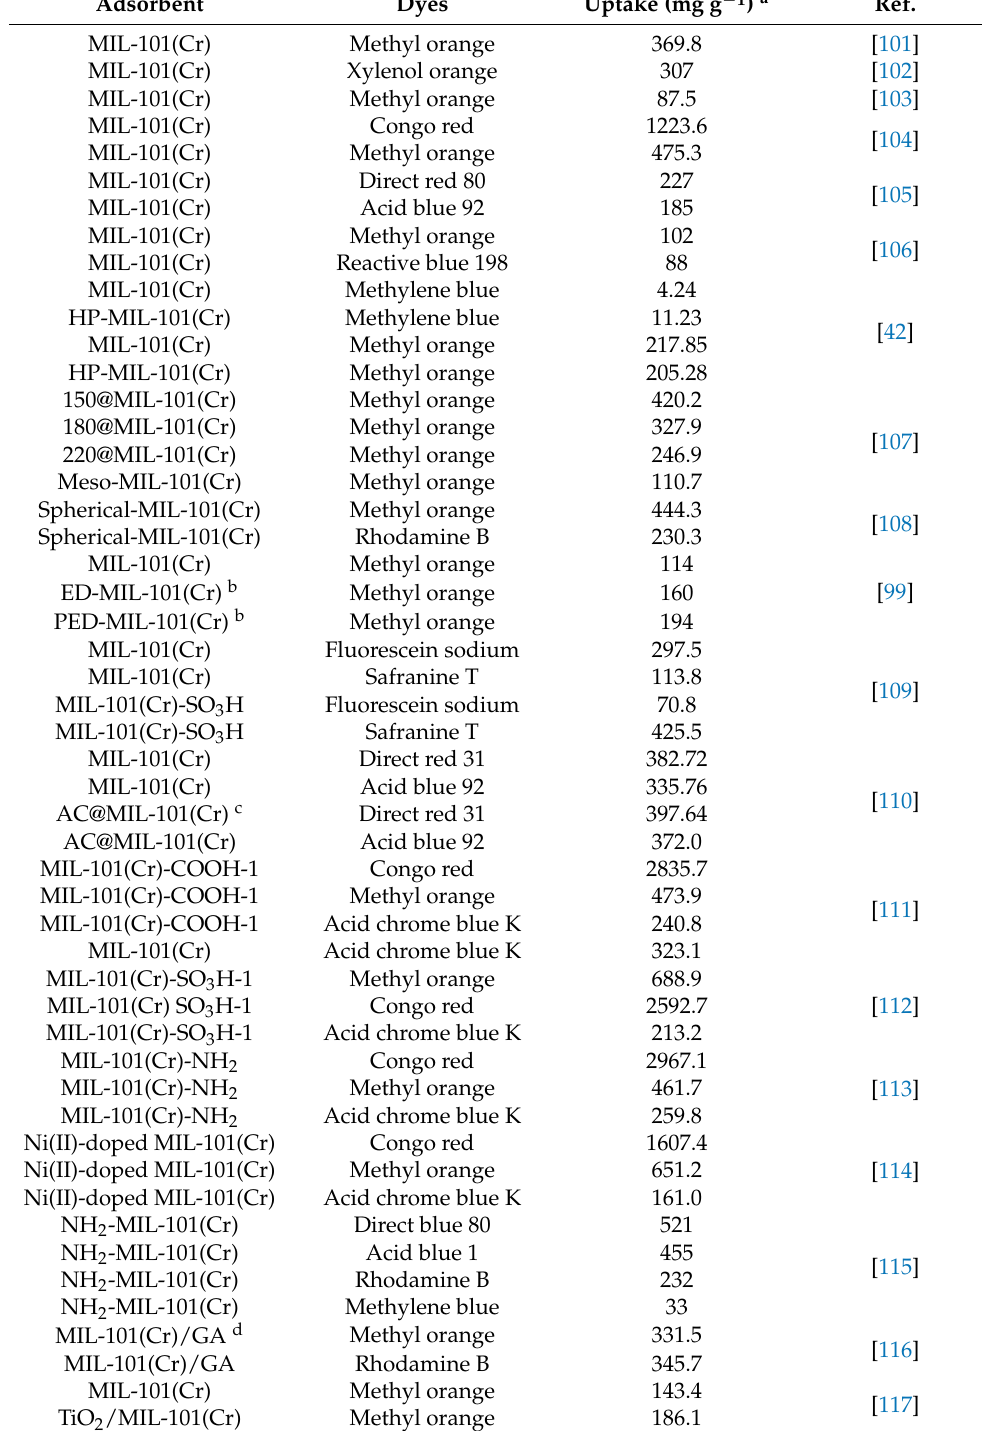
Table 3. Summary of dyes adsorption for MIL-101(Cr) or MIL-101(Cr)-based